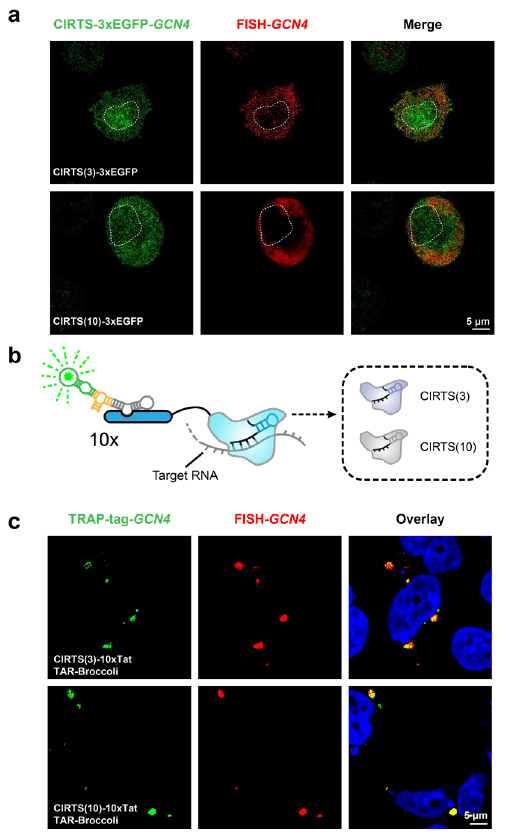
Figure 4. Combination of CIRTS(3)/CIRTS(10) with TRAP-tag for GCN4 RNA imaging. ( a ) Repre- sentative images of GCN4 labeled using CIRTS(3)-3 × EGFP and CIRTS(10)-3 × EGFP with gRNAs. ( b ) Schematic of combination CIRTS(3)/CIRTS(10) with TRAP-tag. ( c ) Representative images of GCN4 -labeled using CIRTS(3)/CIRTS(10) and TRAP-tag with gRNAs.